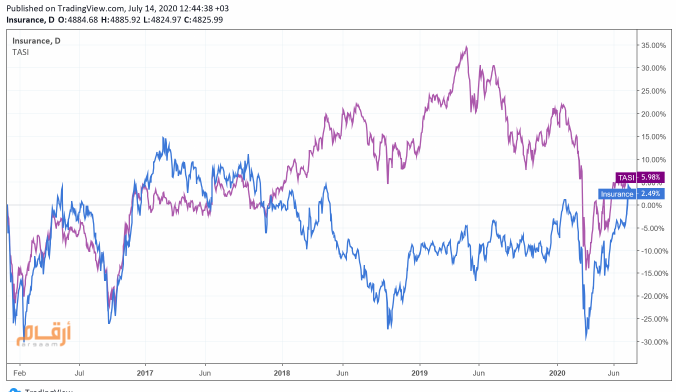
Figure 3. TASI vs. the Insurance sector—in violet, the Tadawul index, in blue, the insurance stock index. Source Argaam (2020).